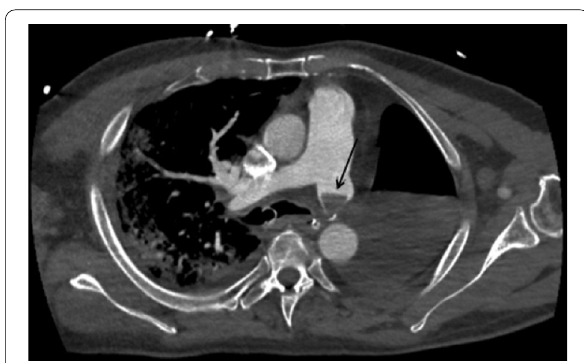
Fig. 6 Alluvial thrombus. Axial CT image (mediastinal window) showing an alluvial thrombus in the left pulmonary arterial stump (black